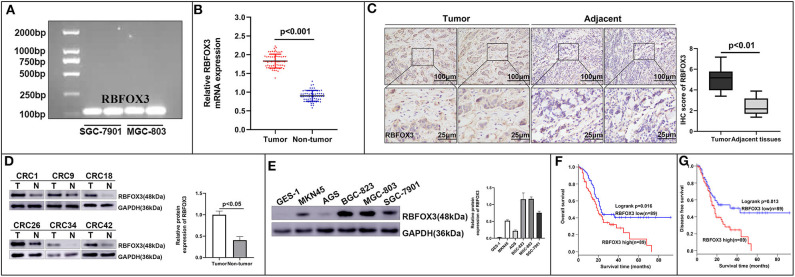
High RBFOX3 protein expression predicted a dismal prognosis of gastric cancer (GC) patients. (A) RBFOX3 DNA digested fragment expression was examined via agarose gel electrophoresis in SGC-7901 as well as MGC-803 cells. (B) RT-qPCR was conducted in GC tissue samples (n = 47) and the corresponding precancerous tissue samples (n = 47) to determine RBFOX3 mRNA expression. (C) Representative images showing the immune-histochemical findings of RBFOX3 in normal gastric mucosa and GC tissues (n = 89). (D) The expression of RBFOX3 protein in 37 human GC tissues and the adjacent tissues as detected by Western blot analysis. (E) The protein expression level of RBFOX3 in normal gastric epithelial cells (GES-1) compared with GC cell lines (MKN45, AGS, SGC-7901, MGC-803, and BGC-823). (F,G) Kaplan–Meier survival analysis of the overall survival and the disease-free survival in the two groups designated by low and high expression of RBFOX3 in patients with GC.